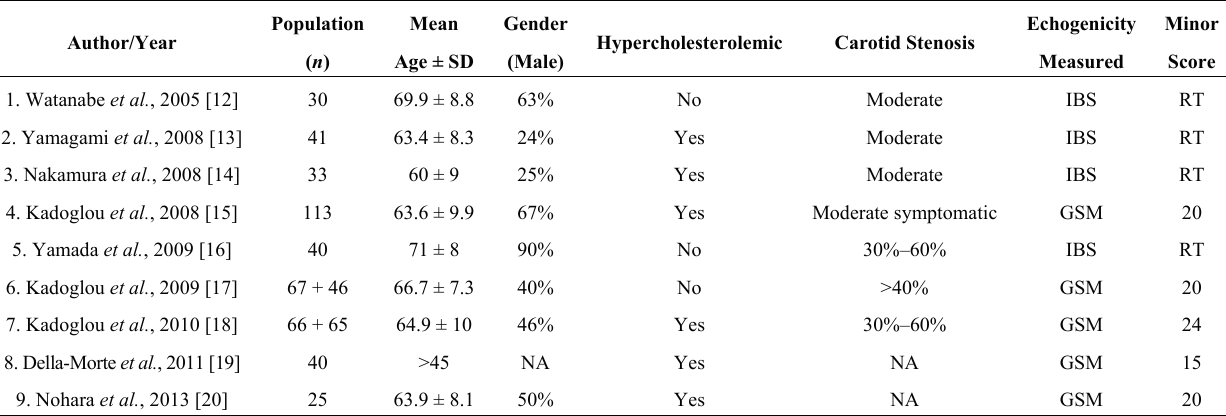
Table 1. Studies included in